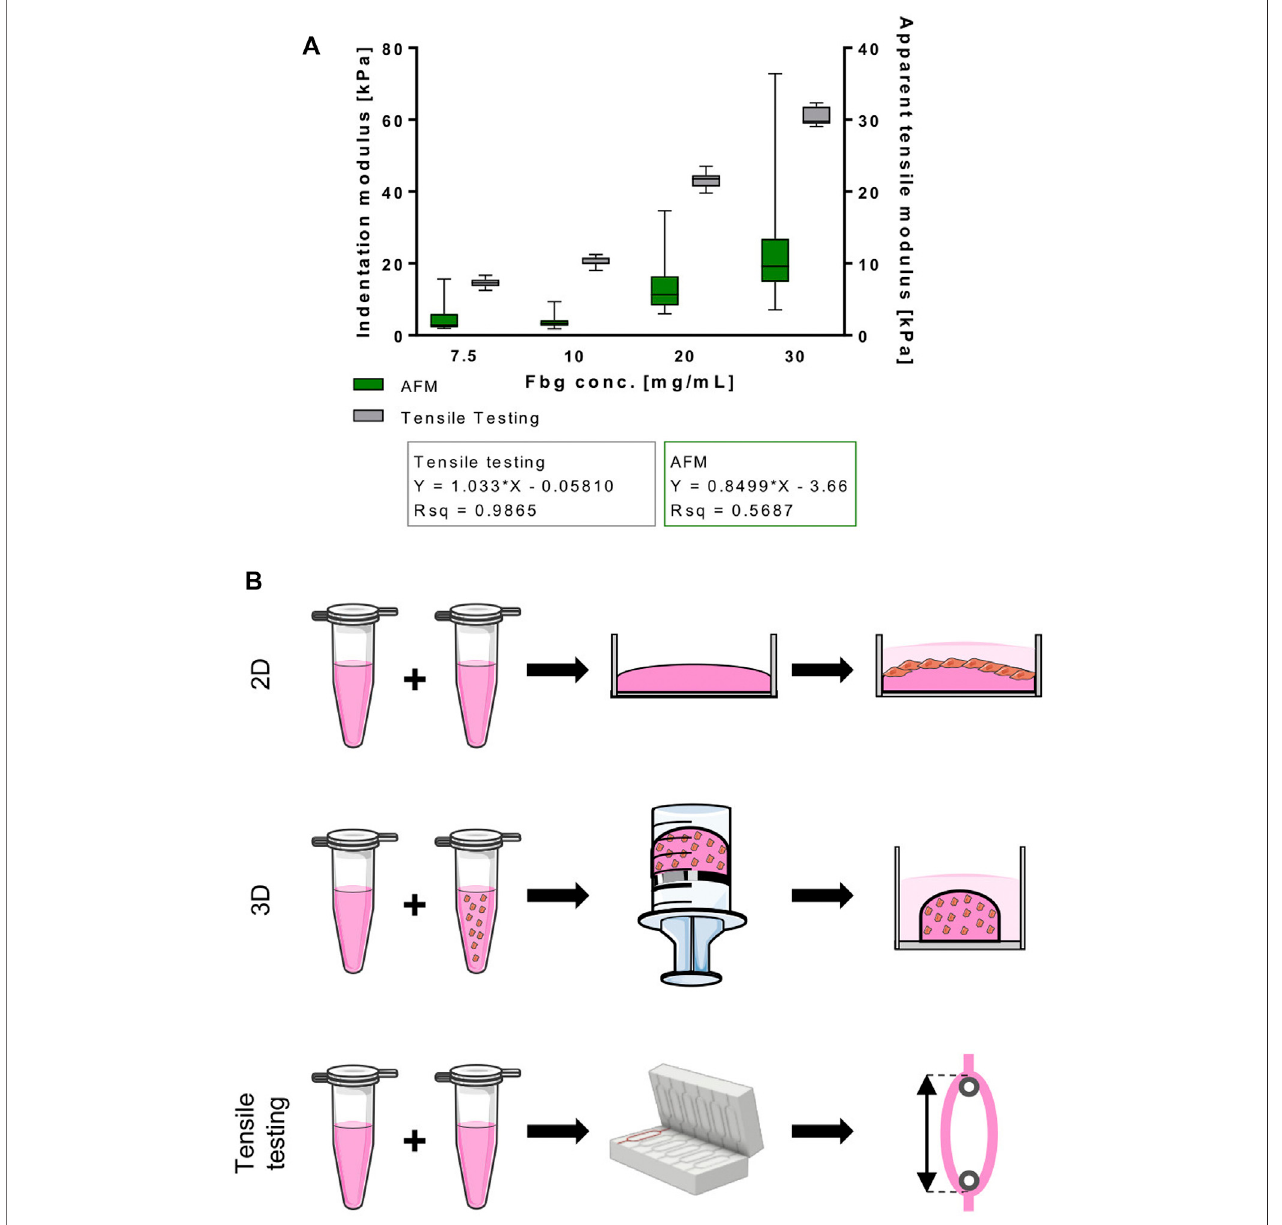
FIGURE1| Normalizedstiffnessof fi brinhydrogelsusedinthisstudycorrelatesdirectlywith fi brinogencontent. (A) Indentationandapparenttensilemodulus[kPa] of fi brinhydrogelswithdifferent fi brinogenconcentrations[mg/ml]acquiredthroughAFMindentationandtensiletesting,respectively.Dataisshownasboxandwhiskers (min tomax); N ≥ 2, n ≥ 6for tensiletesting and N =2, n =2AFM. (B) Hydrogel types usedin thisstudy. 2D: cellswereseededon topof fi brin-coated wells ofcellculture well-plates; 3D: cells were incorporated into fi brin hydrogels that were polymerized in 2 ml syringes and transferred to cell culture well-plates afterwards; tensile testing: fi brin hydrogels were cast in a ring shape and mounted onto spools for tensile testing.